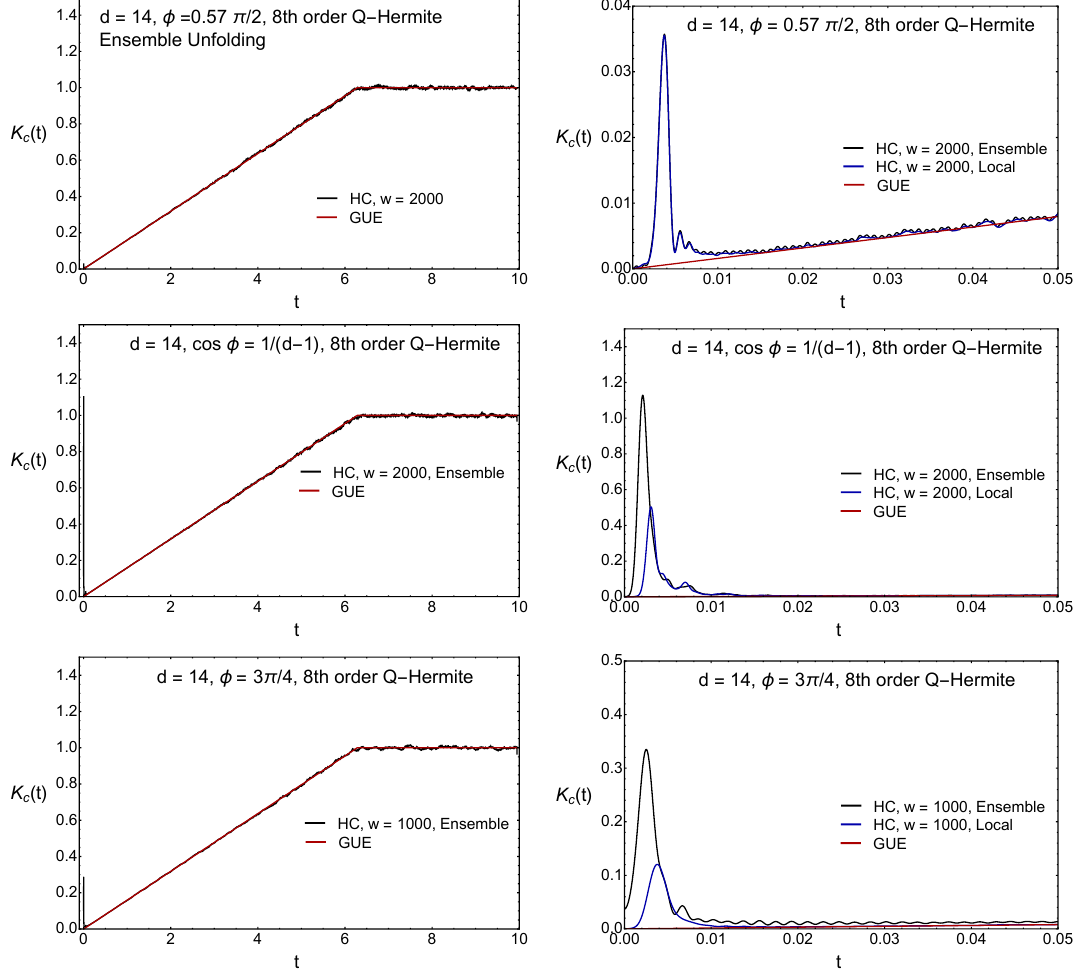
Figure 7 . The ensemble-unfolded spectral form factor for d = 14 at φ = 0 . 57 π/ 2 , φ = 0 . 95 π/ 2 and φ = 3 π/ 4 (black curves). The results are compared with the result for the GUE (red curves). In the left figure, a careful observer can see a tiny peak at τ close to zero which is responsible for the large deviation of the number variance from the universal GUE result. This peak is magnified in the right figure (black curve), where we also show the result for local unfolding (blue curve). Ensemble unfolding and local unfolding give almost indistinguishable results for φ = 0 . 57 π/ 2 . If the results of local unfolding were plotted in the left figures, the differences with the ensemble unfolding results would not be visible for any of the three